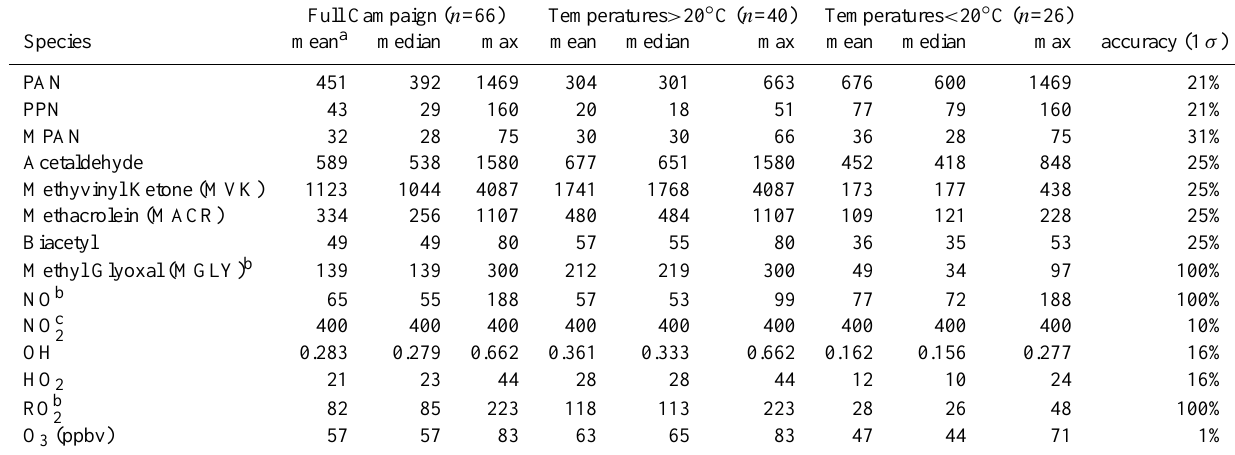
O 3 (ppbv) a All concentration units are pptv unless otherwise noted. b Concentrations inferred (see text) and given a conservative factor of 2 uncertainty. c Average NO 2 concentration used for entire analysis. Figure 3 1 Fig. 3. Diurnal hourly medians of oVOC precursors to APNs: methacrolein, propanal, and acetaldehyde/methylvinyl ketone (ac- etal/MVK) (left side, top to bottom) and APNs: MPAN, PPN, and PAN (right side, top to bottom). The bars represent the 1 σ variance of the mean.